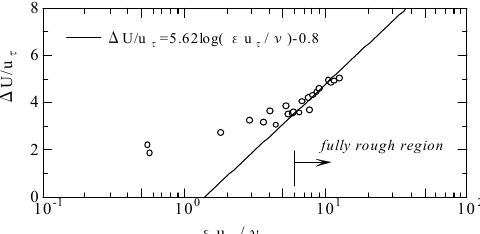
Fig.6 Correlation of the roughness function with the roughness Reynolds number based on